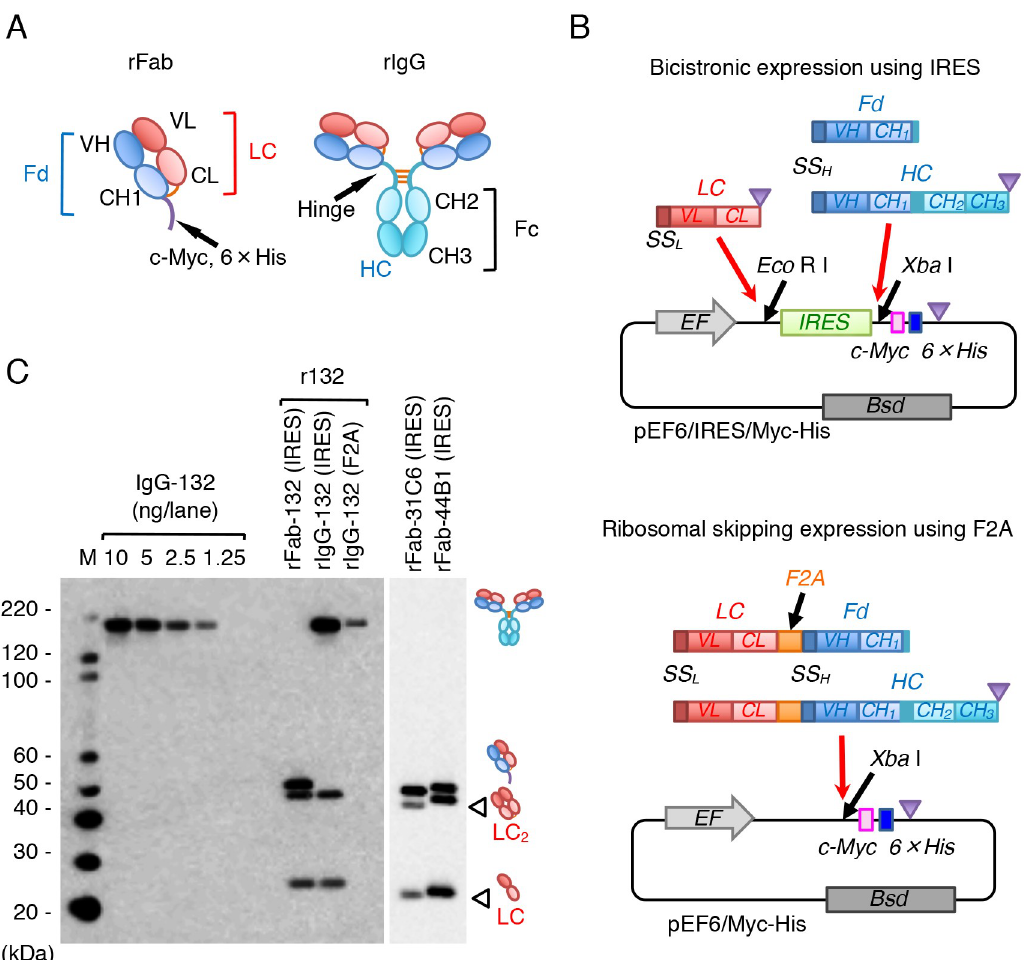
Fig 1. Production of recombinant antibody fragments. (A) Molecular design of mono- (rFab) and bivalent forms (rIgG). The light chain and full length (HC) or VH-CH1 region (Fd) of the heavy chain are depicted with reddish and bluish colors, respectively. Intermolecular disulfide bonds are drawn in orange lines, whereas the C-terminal epitope tail consisting of a c-Myc epitope (c-Myc) and a hexa-histidine tag (6 × His) is drawn in purple. Fc, fragment crystallization; CH1-3, constant domains 1–3 of heavy chain; CL, constant domain of light chain, VH, variable region of heavy chain; VL variable region of light chain. (B) Schematic illustration of two expression systems. DNA fragments for an internal ribosome entry site (IRES) and self-cleavage 2A peptide from foot-and-mouth virus (F2A) are shown in green and orange, respectively. For producing antibody fragments into culture supernatants, heavy and light chain genes possess their own signal sequences (SS H and SS L , respectively) at the 5’- terminus. The gene encoding the Fd region was amplified without a stop codon (purple triangles) to add the epitope tags c-Myc and 6 × His at the 3’-terminus (S1B Fig and S2 Table). EF, a promoter of the human elongation factor gene; Bsd, blasticidin- resistant gene. (C) Analysis of molecular assembly of antibody fragments. Immunoblot analysis was carried out using authentic mAb 132 (IgG-132, 1.25–10.0 ng/lane) and supernatants of HEK293T cells transfected with expression plasmids containing IRES (rFab, rIgG) or F2A (rIgG) under non-reducing condition. Blot was probed with an HRP-conjugated anti-mouse IgG (Fab specific) (Sigma). Corresponding pictures on the right indicate the bands of IgG, rIgG, or rFab, whereas arrowheads indicate the bands of free and dimeric LC (LC 2 ). Molecular mass markers on the left are in